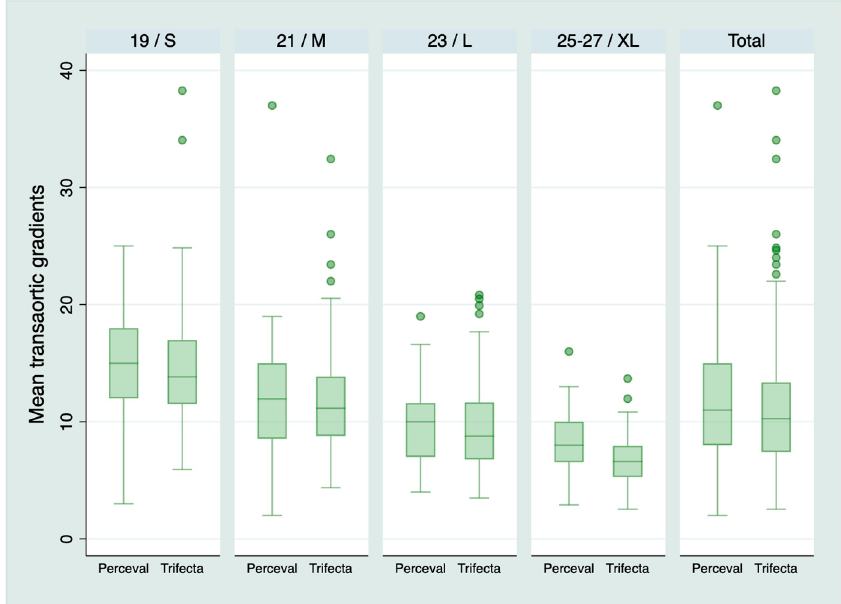
Figure 1. Mean transaortic gradients according to the type of prosthesis and size. Both types of prosthesis are presented together for visual inspection. However, size S of the Perceval is for an aortic annulus of 19–21 mm. Size M: 21–23 mm. Size L: 23–25 mm. Size XL: 25–27 mm [6]. Therefore, the size of a Perceval does not match the size of any Trifecta.